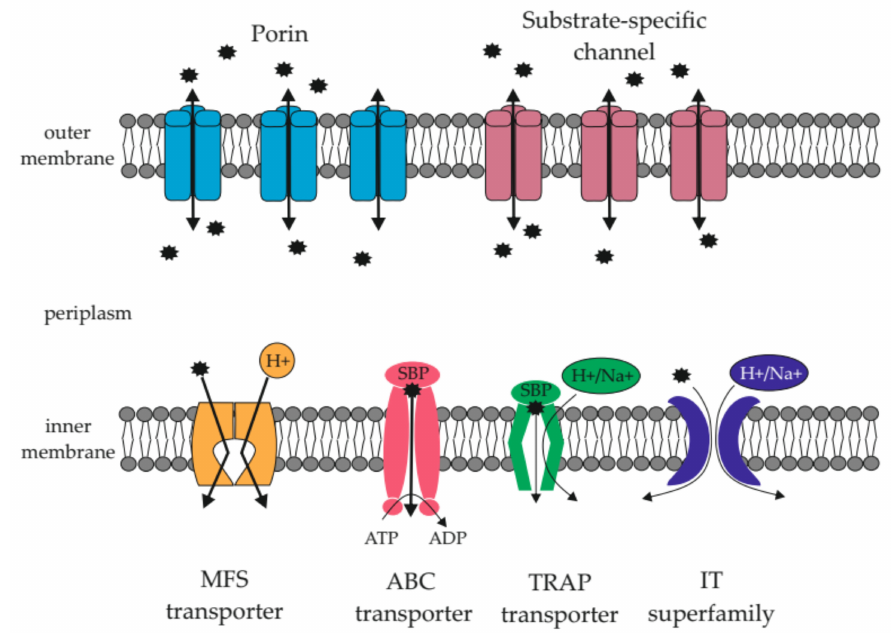
Figure 1. Some transporter systems of Gram-negative bacteria. MFS—major facilitator superfamily; ABC—ATP-binding cassette; TRAP—tripartite; ATP—independent periplasmic (TRAP) transporters; IT—ion transporter; SBP—solute binding protein. Table 2. β -barrel porins of Y. ruckeri KMM821, Y. pseudotuberculosis 598, and M. primoryen- sis KMM3633 T